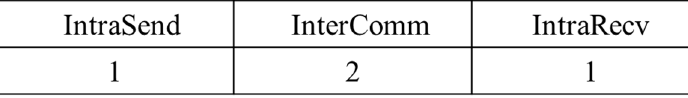
Figure 1. Minor Figure 1. Minor frame.